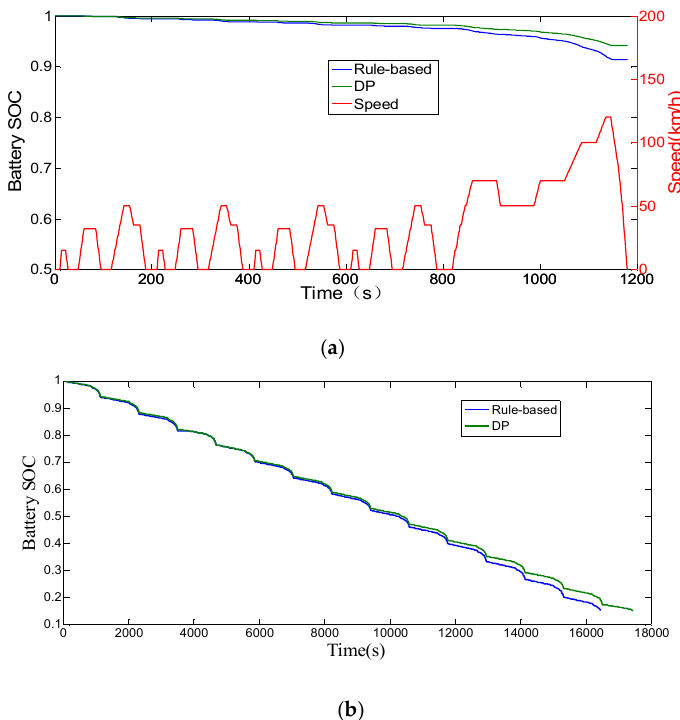
Figure 17. SOC change of battery under NEDC condition. ( a ) SOC change of battery under single NEDC condition; ( b ) SOC change of battery under multiple NEDC condition.